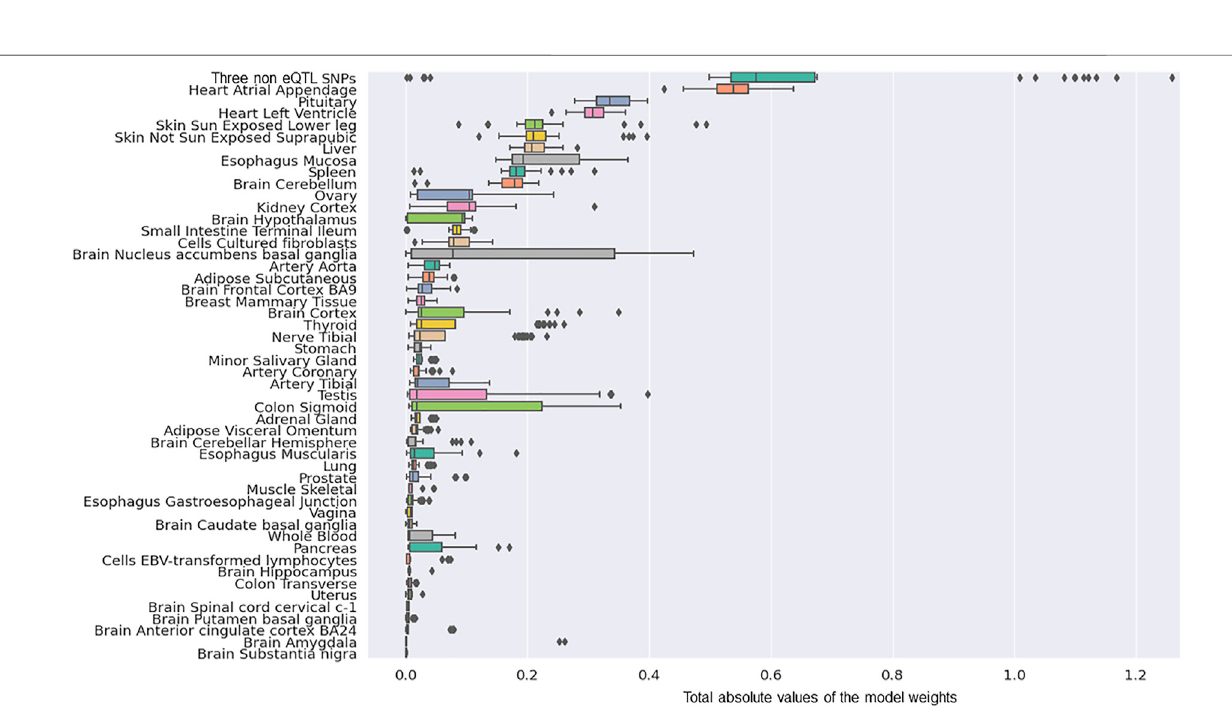
Frontiers in Genetics |